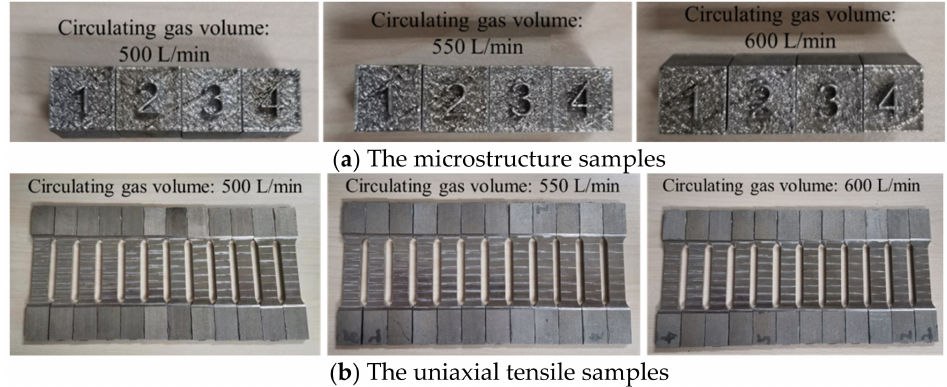
Figure 4. The samples fabricated by SLM with different shielding gas volume flow.